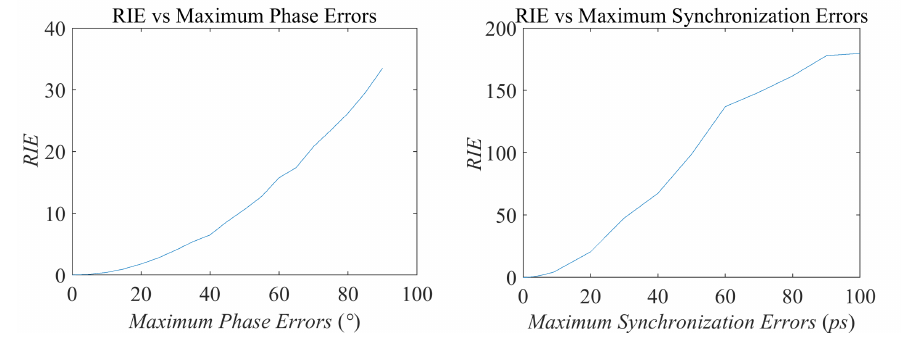
Figure 10. RIE versus different types of imaging